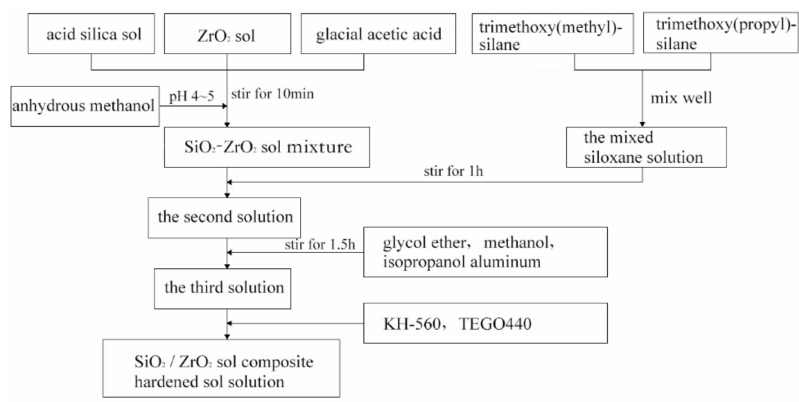
Figure 1. Preparation flow chart of SiO 2 / ZrO 2 sol composite-hardening sol solution.